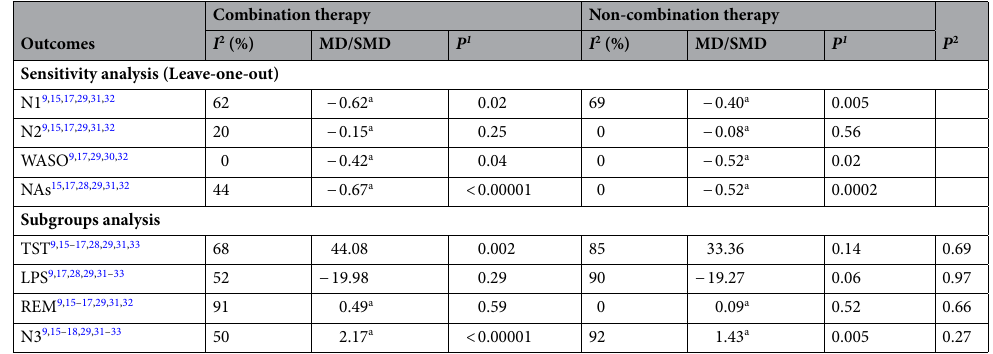
Table 6. Analysis on combination with other therapies. MD mean differences, SMD standardized mean differences, TST total sleep time, LPS latency to onset of persistent sleep, N1 non-rapid eye movement stage 1, N2 non-rapid eye movement stage 2, N3 non-rapid eye movement stage 3, REM rapid eye movement, NAs the number of awakenings, WASO wakefulness after persistent sleep onset, P 1 variation within the group, P 2 differences between subgroups. a